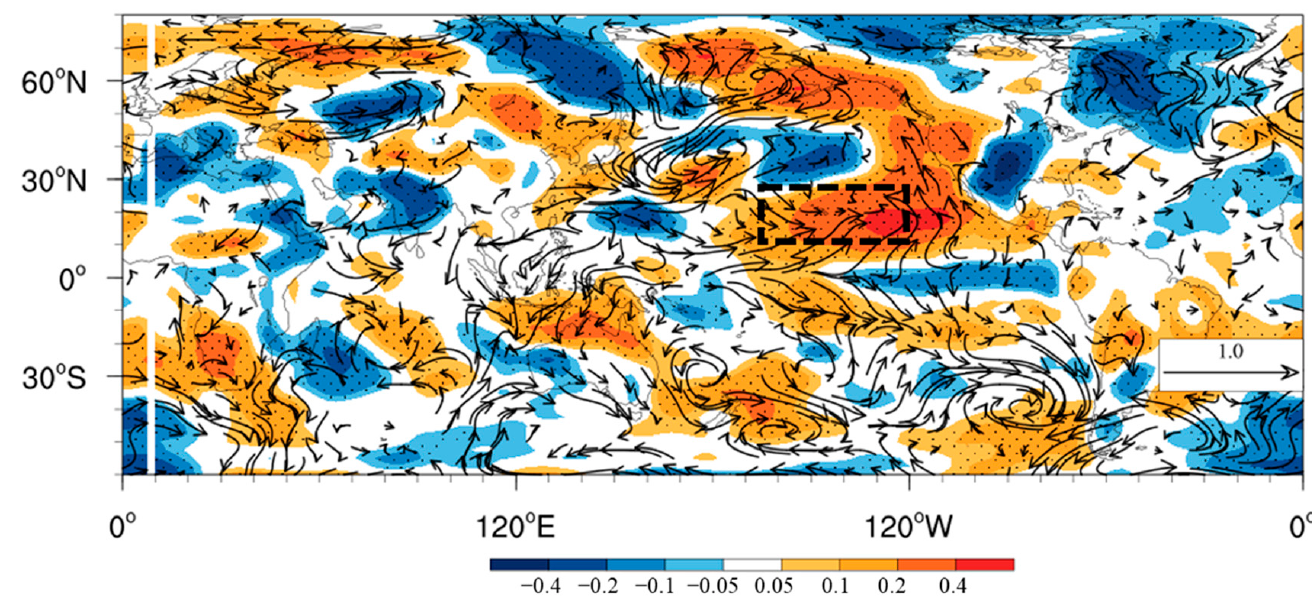
Figure 6. Regressed July t2m (shading; K) and surface wind (vector; m s − 1 ) anomalies onto NCDT from the observations. The black dotted box denotes the location of the Northeast Pacific. Stippling indicates significance at the 95% level from Student’s t -test. Black vectors are significant regressed surface wind anomalies at the 90% level from Student’s 𝑡 -test.